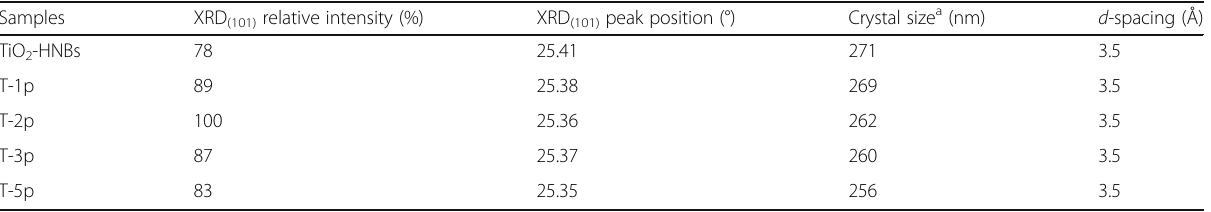
Table 1 Structural analysis of various samples Samples